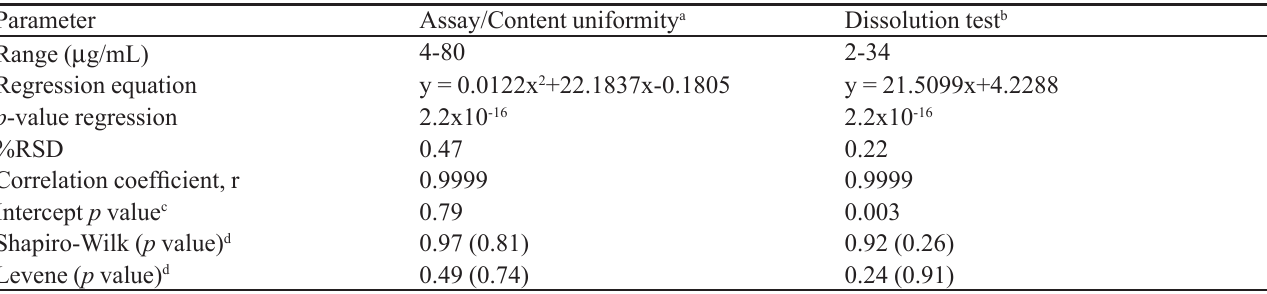
TABLE III – Statistical regression results by ANOVA for SIM assay/content uniformity and dissolution test by HPLC (chromatographic conditions, Figure